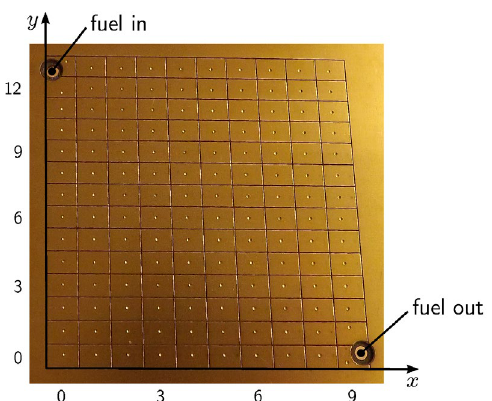
Fig. A1. Scheme of current scan segments.